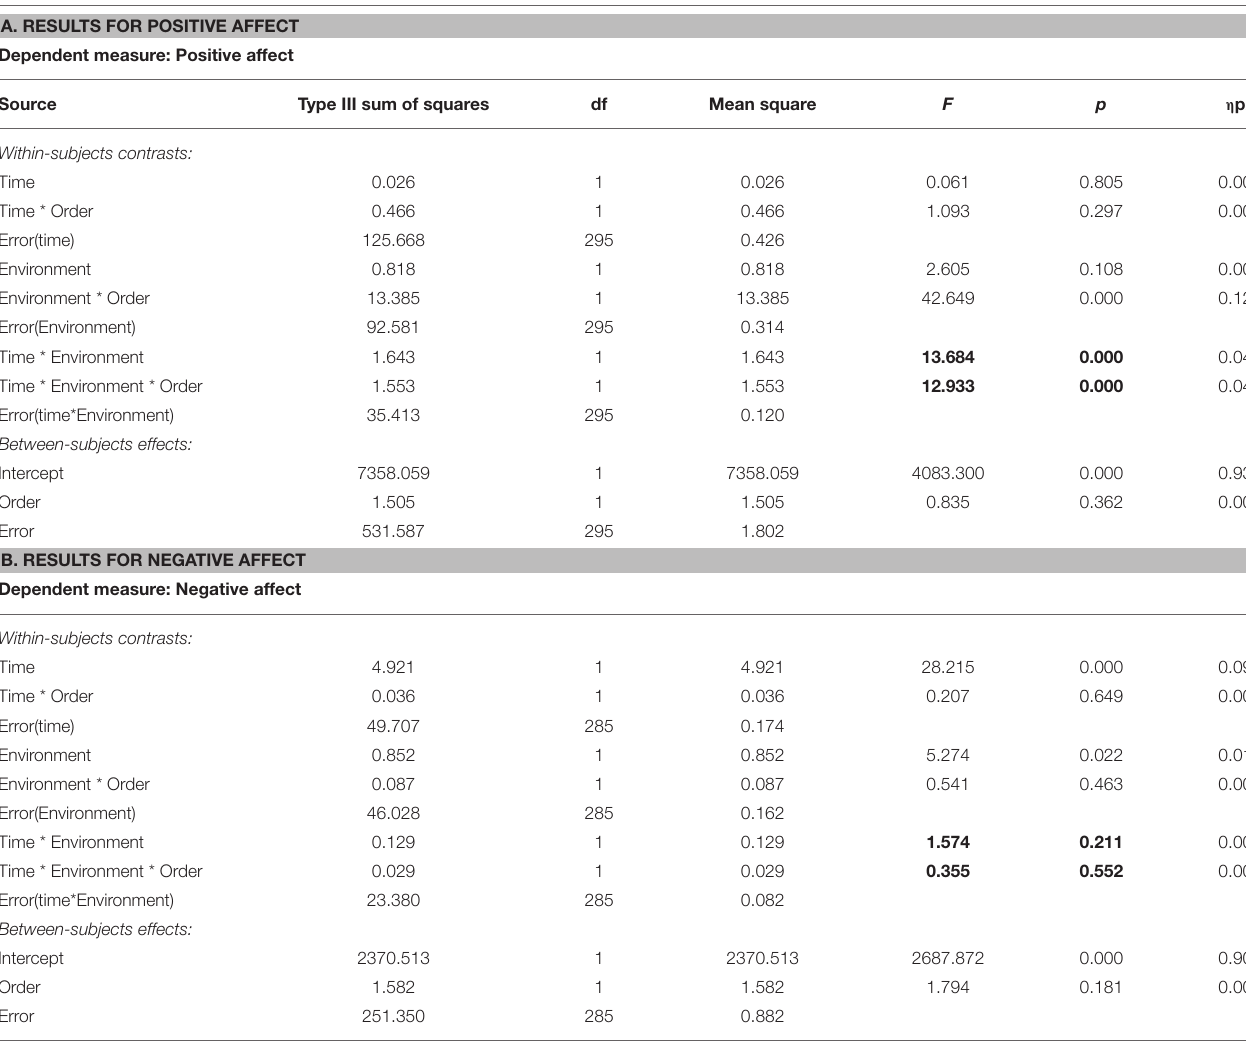
TABLE 6 | Results from ANOVAs on time (pre, post) × environment (nature, urban) × order (nature 1st, urban 1st) effects on positive affect and negative affect, for study samples with environment as a Within-subjects